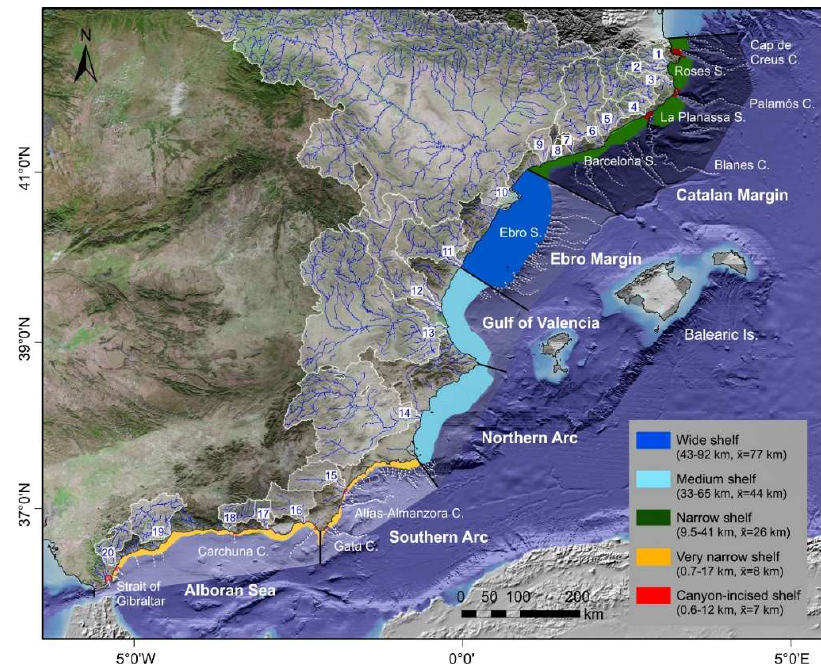
Figure 3. Shaded-relief map of the Mediterranean margin of the Iberian Peninsula including continental shelves and their specific widths. x: mean width of each sector. The northern sector comprises the Catalan Shelf. The middle sector includes the Ebro Shelf, the Gulf of Valencia, and the North Arc. The southern sector comprises the Southern Arc and the northern Alboran Shelf. Numbers correspond to the studied rivers: Muga (1), Fluvi à (2), Ter (3), Tordera (4), Bes ó s (5), Llobregat (6), Foix (7), Gai à (8), Francol í (9), Ebro (10), Mijares (11), Turia (12), J ú car (13), Segura (14), Almanzora (15), Andarax (16), Adra (17), Guadalfeo (18), Guadalhorce (19) and Guadiaro (20). The topographic data and the orthophoto were provided by the Spanish National Geographic Institute (www.ign.es). The bathymetric data were extracted from the EMODnet portal (http://portal.emodnet-bathymetry. eu/) and the Catalano-Balearic Sea bathymetric chart [38].